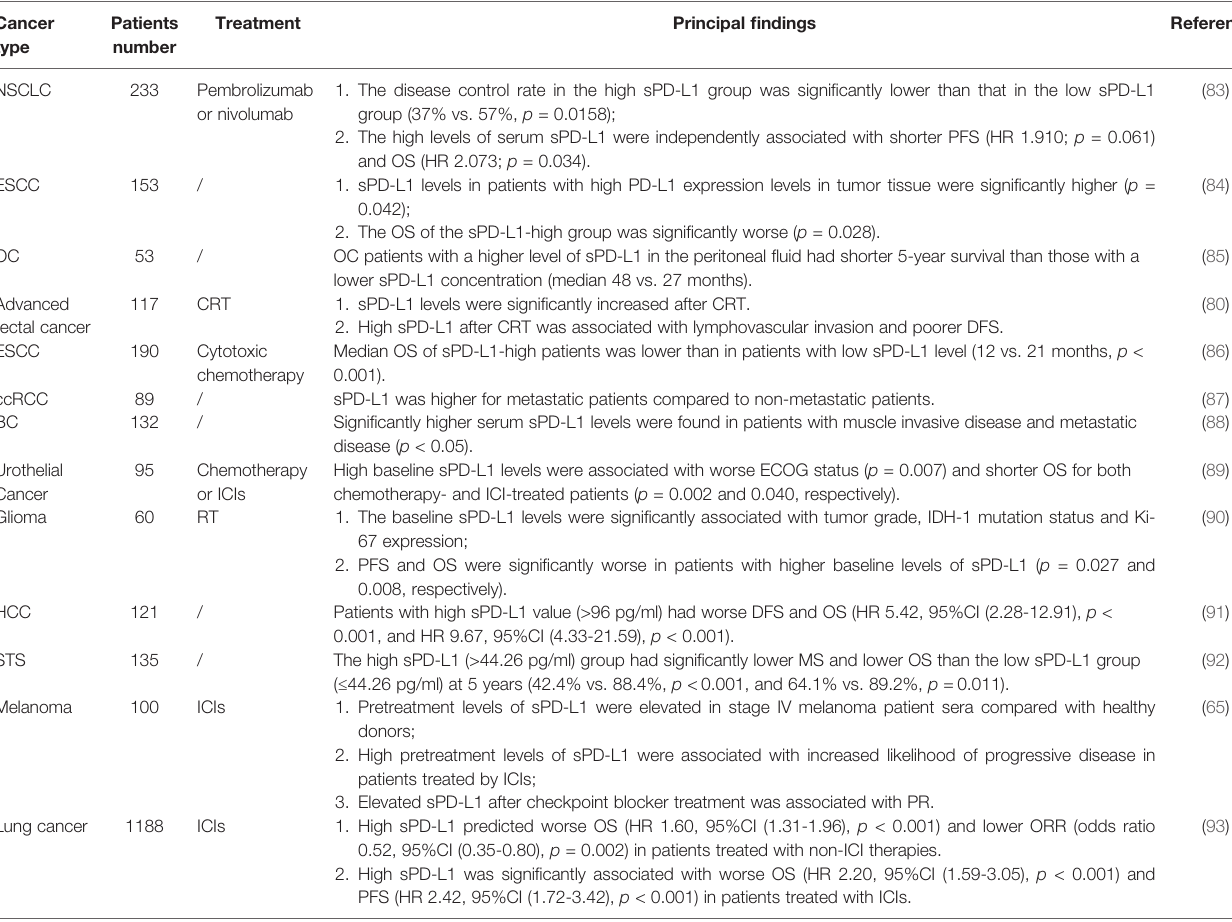
TABLE 2 | Soluble PD-L1 expression levels in different cancers and their correlation with disease prognosis and ef fi cacy prediction. Cancer